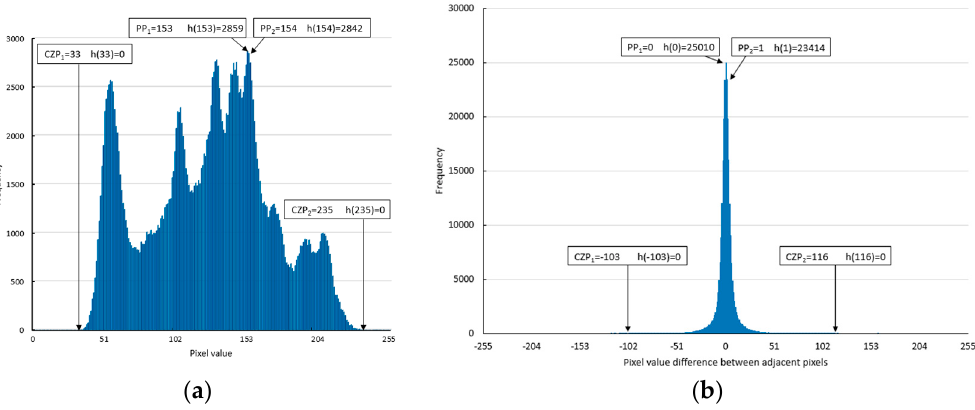
Figure 1. The histogram of Lena and adjacent pixel di ff erence sequence (D). ( a ) The histogram of Lena Figure 1. The h istogram of Lena and adjacent pixel difference sequence (D). ( a ) The histogram of and ( b ) the histogram of the adjacent pixel di ff erence sequence Lena and ( b ) the histogram of the adjacent pixel difference sequence (D)